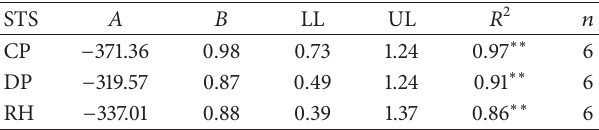
LL: lower limit of confidence interval of the gradient line 𝐵 at the level of 95 % ; UL: upper limit of the confidence interval of the gradient line 𝐵 at the level of 95 % ; 𝑅 2 : determination coefficient; 𝑛 : number of